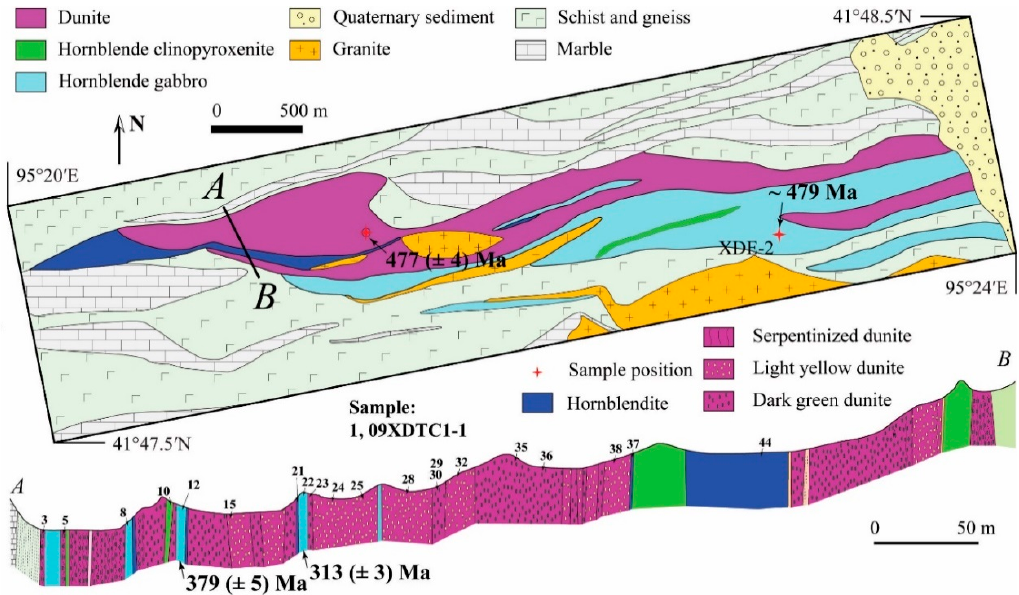
Figure 2. Geological map of the Xiadong mafic–ultramafic complex, accompanied by a horizontal profile along A to B showing its rock units and sampling positions (modified from References [15,17]). Isotopic ages are the U–Pb ages of zircons from four hornblende gabbros.